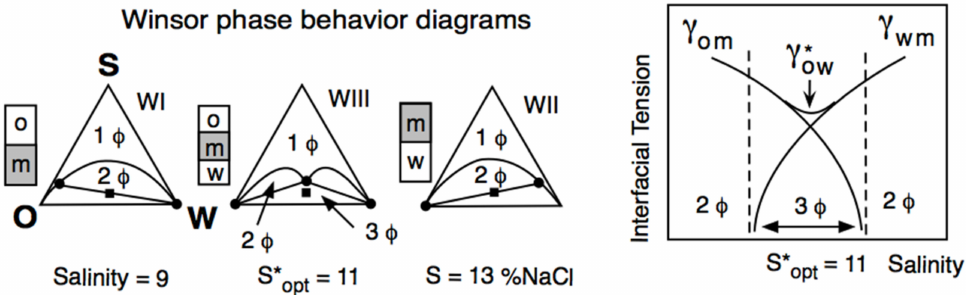
Figure 2. Variation of the interfacial tension (right) and of the phase behavior in a ternary diagram (left) along a formulation unidimensional scan (here, the salinity of the aqueous phase S). S* and γ * are the salinity and the interfacial tension at optimum formulation,